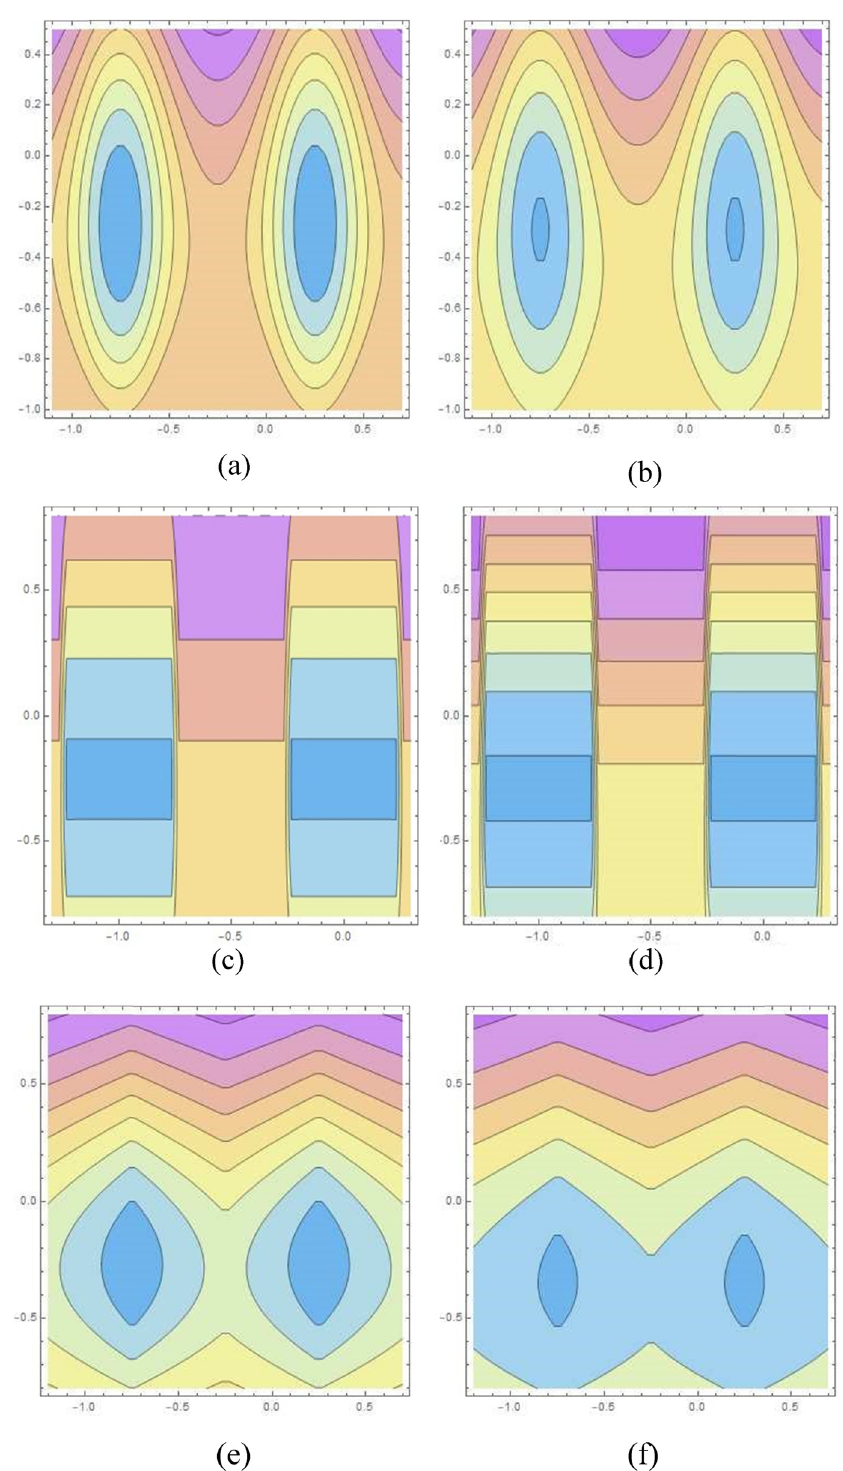
= 0.1, A = 2, Sr = 0.5 A = 1, Br = 0.5, K = 3, Sc = 0.5, ϵ 0.2 = , Gr 0.4 = , 1 3 3 1